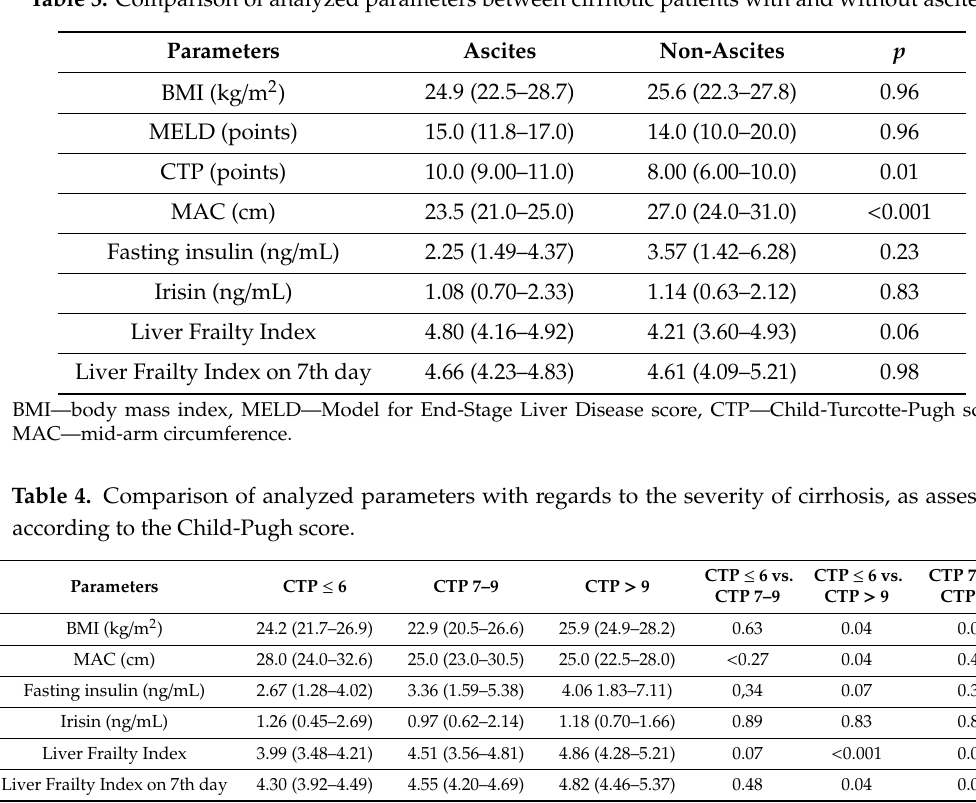
Table 3. Comparison of analyzed parameters between cirrhotic patients with and without ascites.